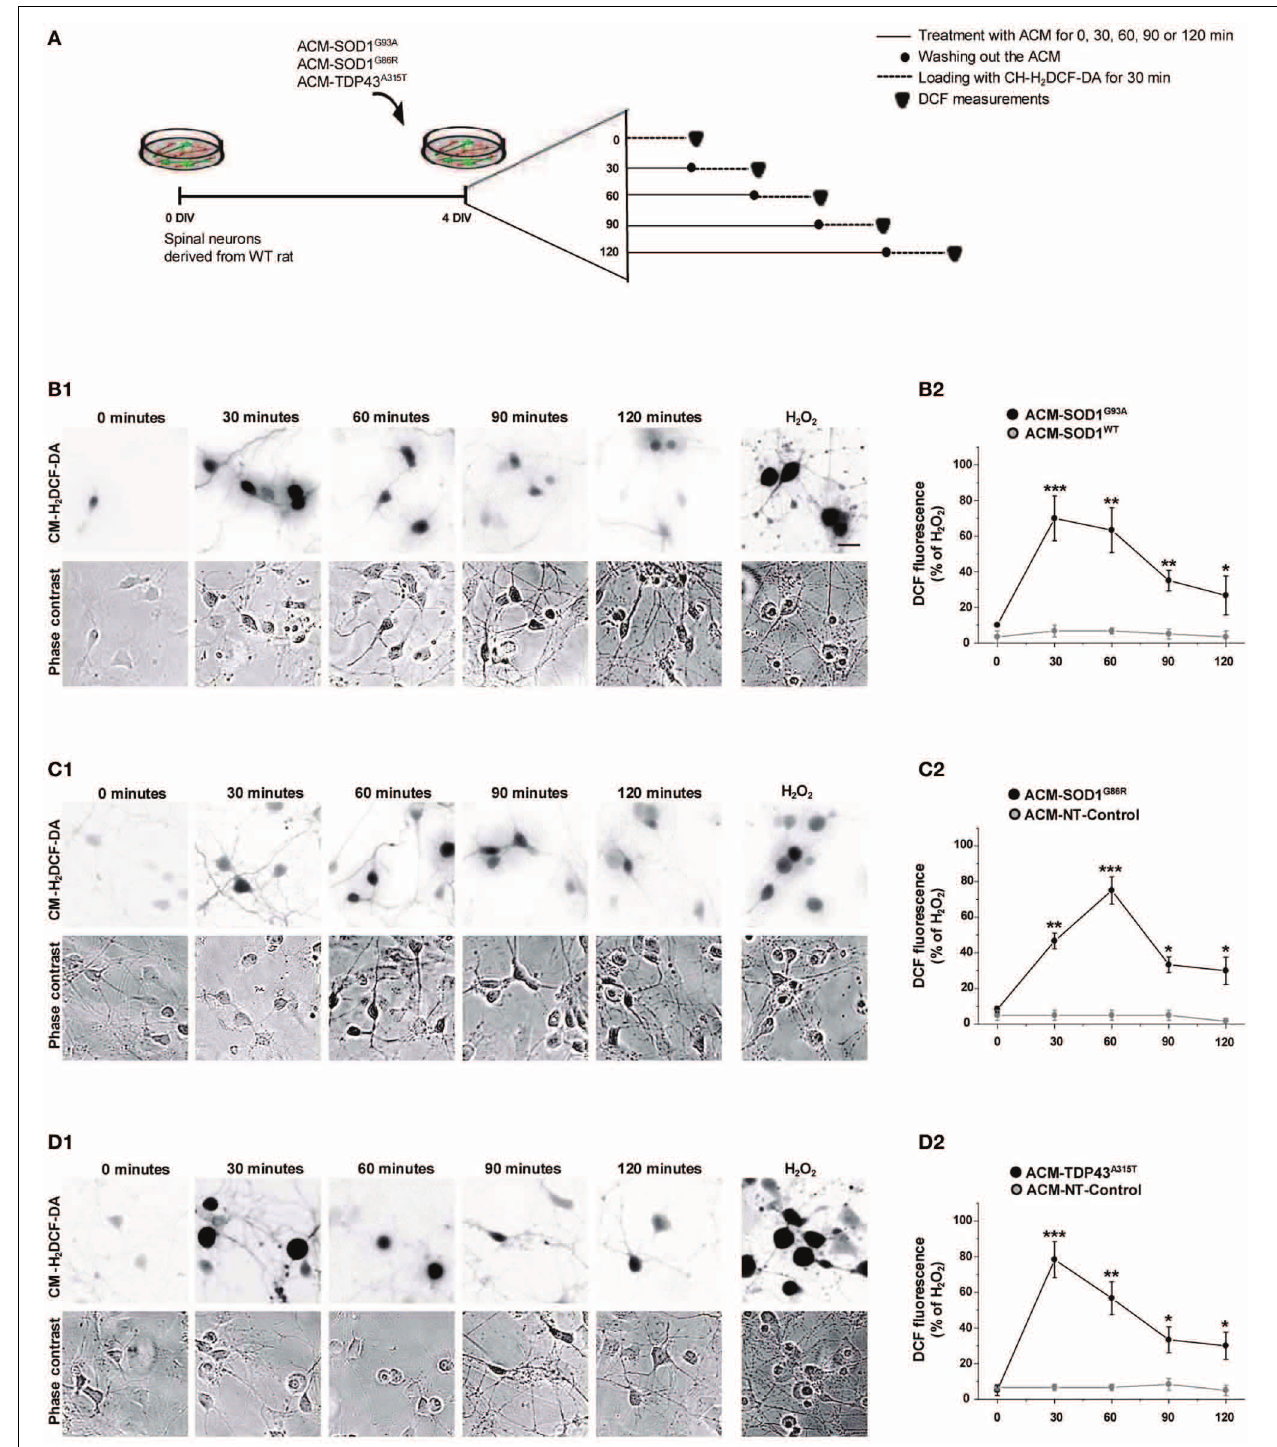
washed and DCF measurements were immediately performed (filled triangles). (B–D) Cultures exposed to ACM-SOD1 G93A (B) , ACM-SOD1 G86R (C), or ACM-TDP43 A315T (D) . (B 1 –D 1 ) The negatives of representative DCF fluorescent images (in which both motoneurons and interneurons are marked) and corresponding phase contrast images of spinal cord cultures photographed at 0, 30, 90 and 120min after application of ACM-SOD1